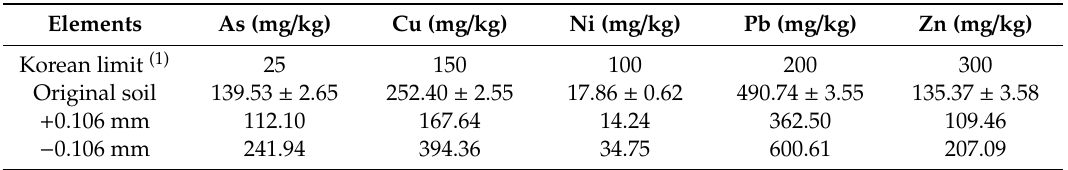
Table 2. Distribution of heavy metal concentrations according to particle size fraction, concentration of original soil, and Korean threshold values.